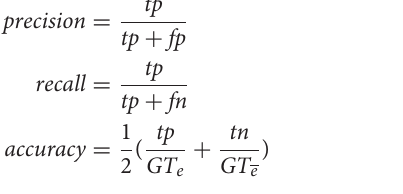
Frontiers in Neurorobotics |